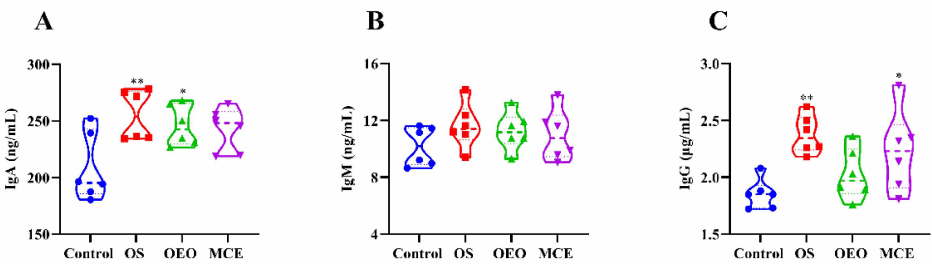
Figure 5. Serum immune indices of broilers. ( A ) Immunoglobulin A (IgA). ( B ) Immunoglobulin M (IgM). ( C ) Immunoglobulin G (IgG). * p < 0.05, ** p < 0.01, vs. control group ( n =